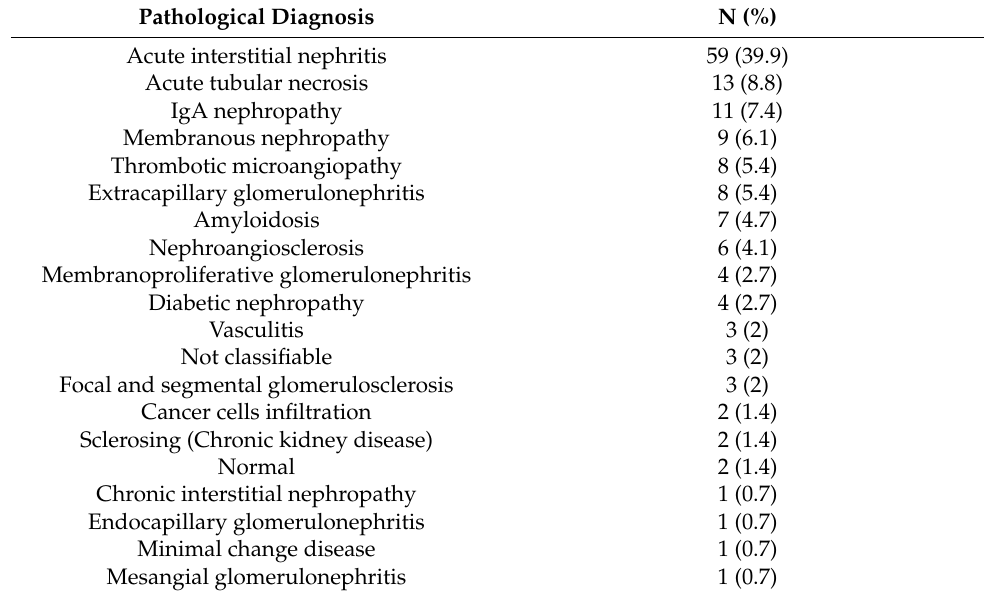
Table 3. Kidney biopsy